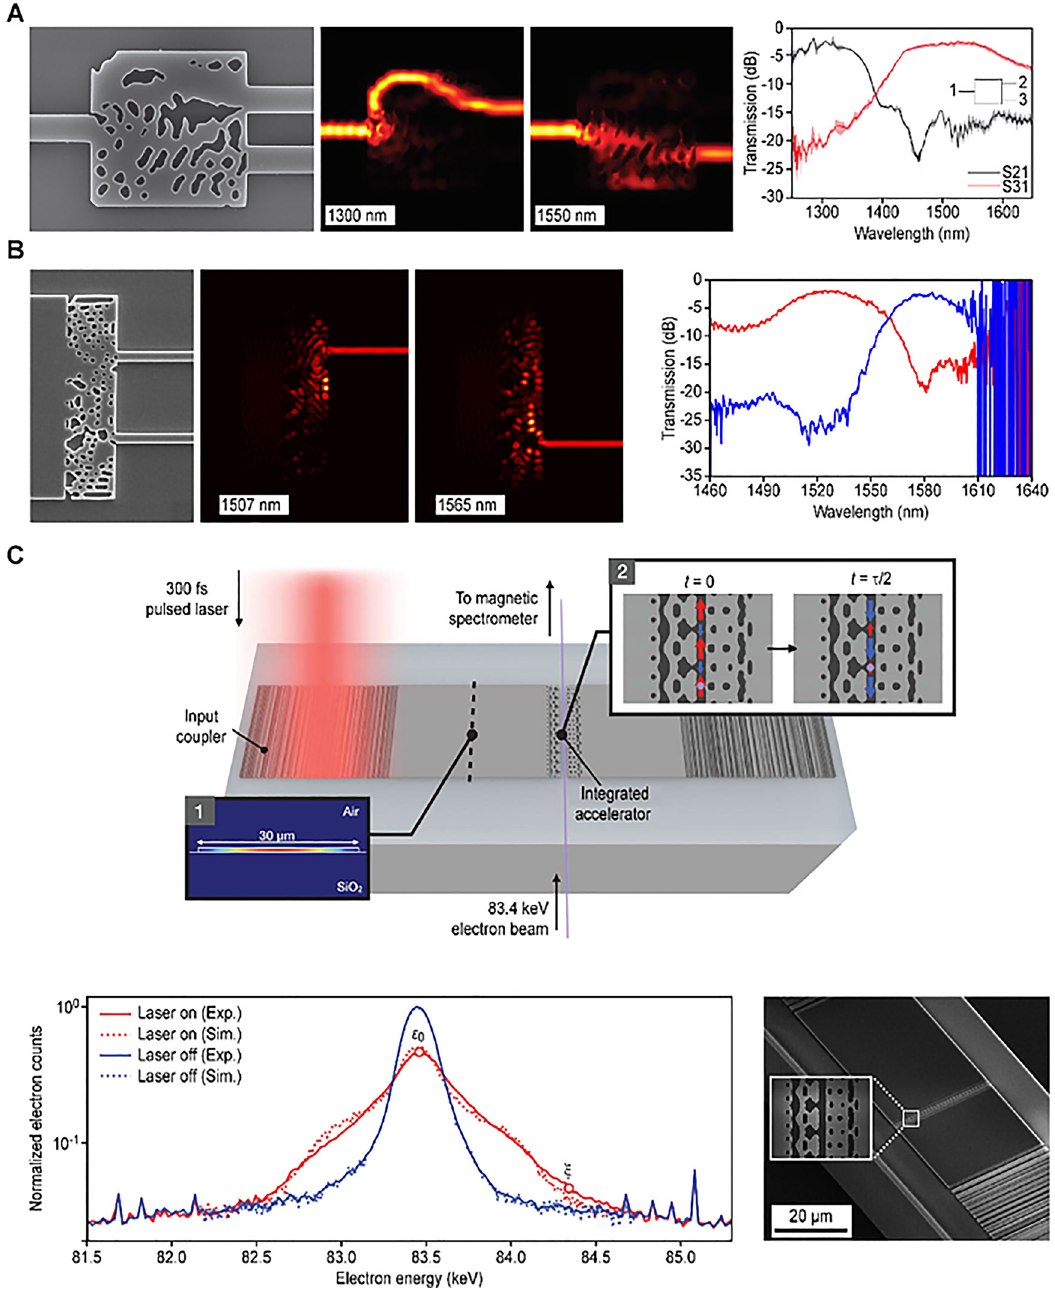
Figure 5: Part of a nanophotonic device designed by the OB-1 algorithm. (A) Broadband on-chip wavelength demultiplexer. Left: SEM image of the fabricated wavelength demultiplexer. Middle: simulated electromagneticenergydensityinahorizontalslicethroughthemiddleofthedevice.Right:Measured S -parametersforthedevice,where S ij is the transmission from port j to port i . Reproduced with permission [18]. Copyright 2015, Nature Publishing Group. (B) Two-channel focussing wavelength demultiplexer. Left: SEM image of the fabricated focussingwavelength demultiplexer. Middle: Simulated electromagnetic energy densityin a horizontal slice through the middle of the device.Right: Measured S -parameters for the device, where S ij is the transmissionfrom port j to port i . Reproduced with permission [33]. Copyright 2020, De Gruyter. (C) On-chip integrated laser-driven particle accelerator. Upper left: Schematicdepicting the components of the on-chip accelerator composed of pairs of inverse-designed grating couplers and the inverse- designed integrated accelerator. Lower left: Electron energy spectrum (log scale) without an incident laser (blue curve) and with an incident laser(3.0mW,335MV/mpeak fi eld, λ =1.94 μ m;redcurve)onthegratingcoupler.Right:SEMimageofasingle-stageacceleratorat30periods fabricated on a 500-nm silicon on insulator (SOI) stack. Reproduced with permission [21]. Copyright 2020, American Association for the Advancement of